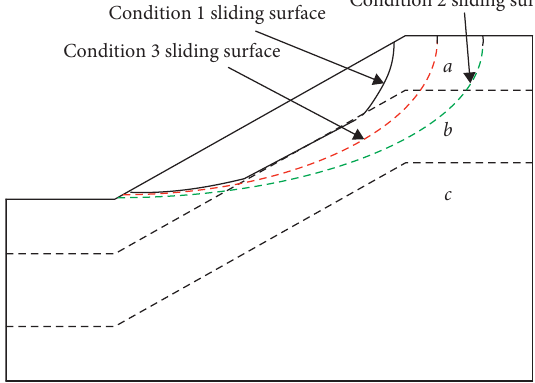
Figure 7: The position of the sliding